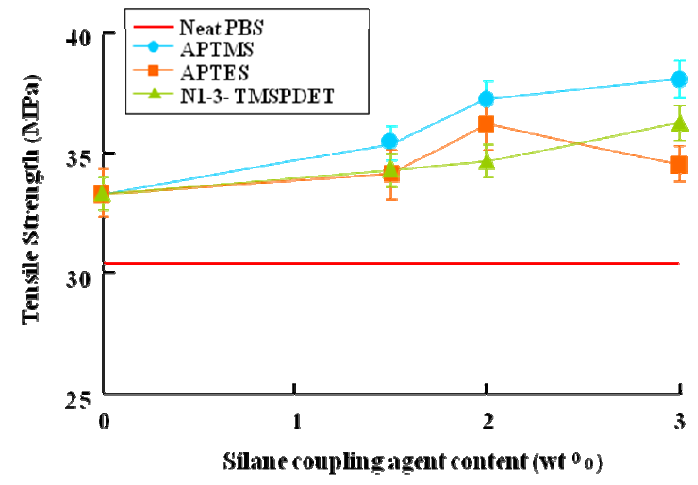
Figure 2. Tensile strength of PBS (90 wt%)/CF (10 wt%) composites with various concentrations of 3-aminopropyltrimethoxysilane (APTMS), 3-aminopropyltriethoxysilane (APTES), and N1-3-trimethoxysilylpropyldiethylenetriamine